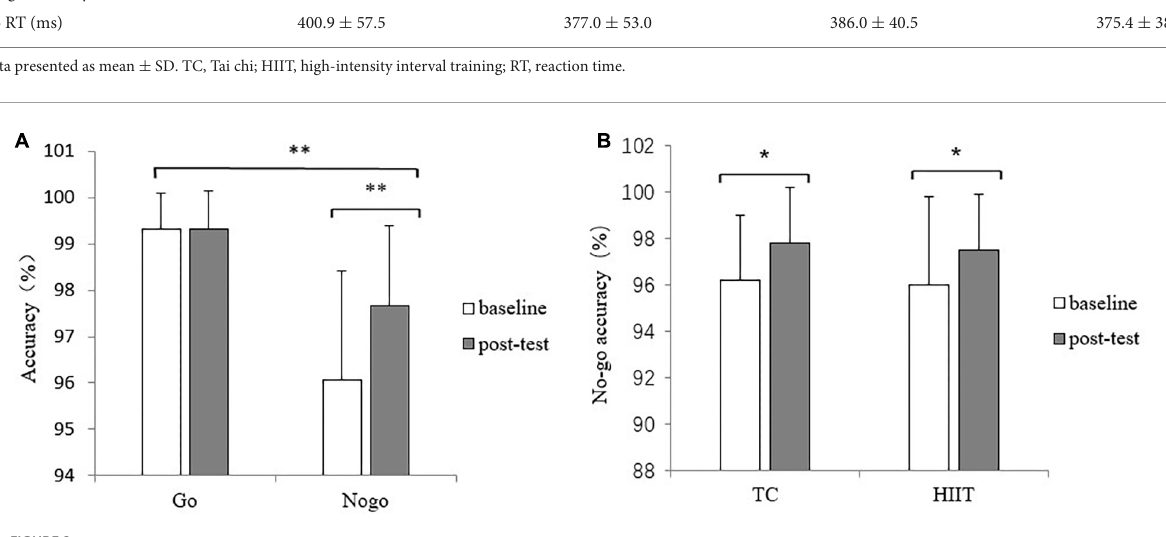
FIGURE2 Changes in the accuracy of the Go/no-go test after TC and HIIT: (A) overall accuracy of two groups of baseline and post-test, (B) No-go accuracy of two groups of baseline and post-test. * p < 0.05, ∗∗ p < 0.01.